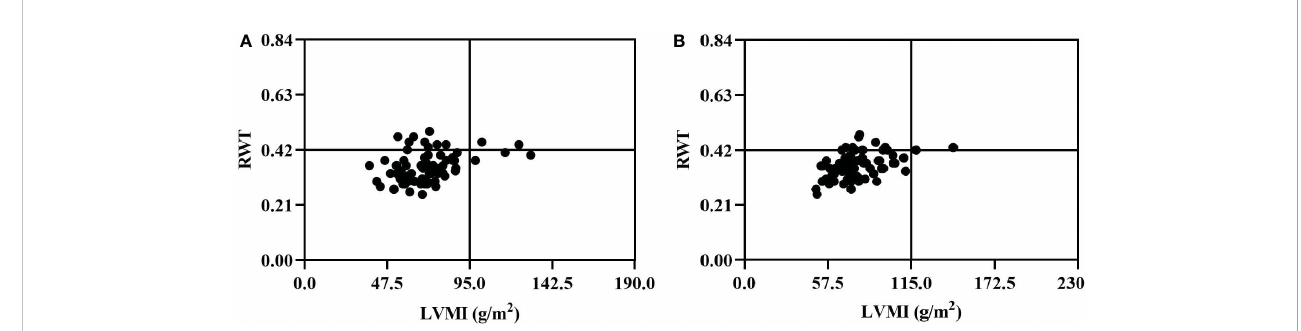
FIGURE 1 Cardiac geometry of female (A) and male (B) patients in 153 PHPT. The normal range of RWT was less than 0.42 in both females and males, and the normal range of LVMI was less than 95.0 g/m 2 in women and less than 115.0 g/m 2 in men. PHPT, Primary hyperparathyroidism; LVMI, left ventricular mass index; RWT, relative wall thickness.